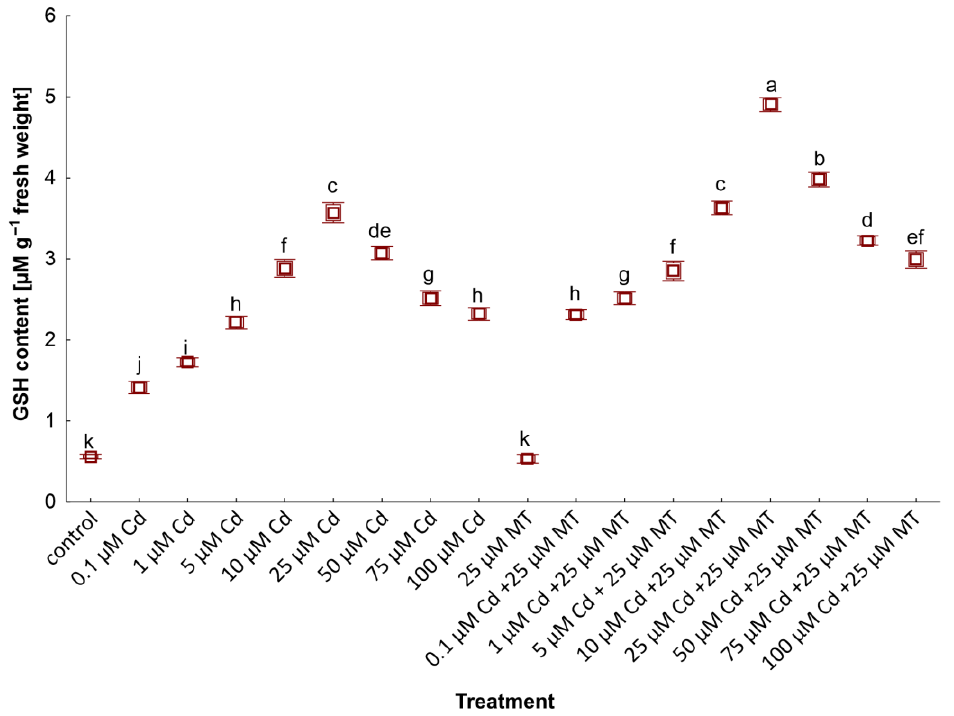
Figure 4. The content of glutathione (GSH) in W. arrhiza exposed to cadmium (Cd) or/with melatonin (MT) after 7 days of cultivation. The square represents the mean ( n = 5, biological replicate). The lower and upper hinges correspond to the lower and upper bounds of the 95% confidence interval of the means. The lower and upper whiskers extend from the hinge to the mean ± standard deviation. Means with the same letters are not significantly different ( p ≥ 0.05) according to Tukey’s post hoc test .